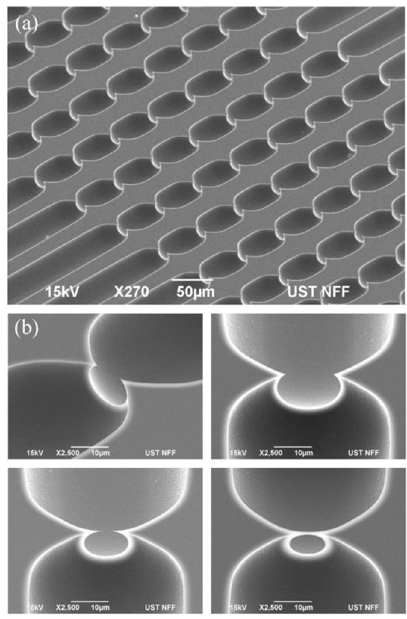
Figure 2. Scanning electron micrographs: ( a ) channels featuring eight single-cell point constrictions and ( b ) constrictions of various sizes in close-up views. Scale bar: ( a ) 50 μm; ( b ) 10 μm.